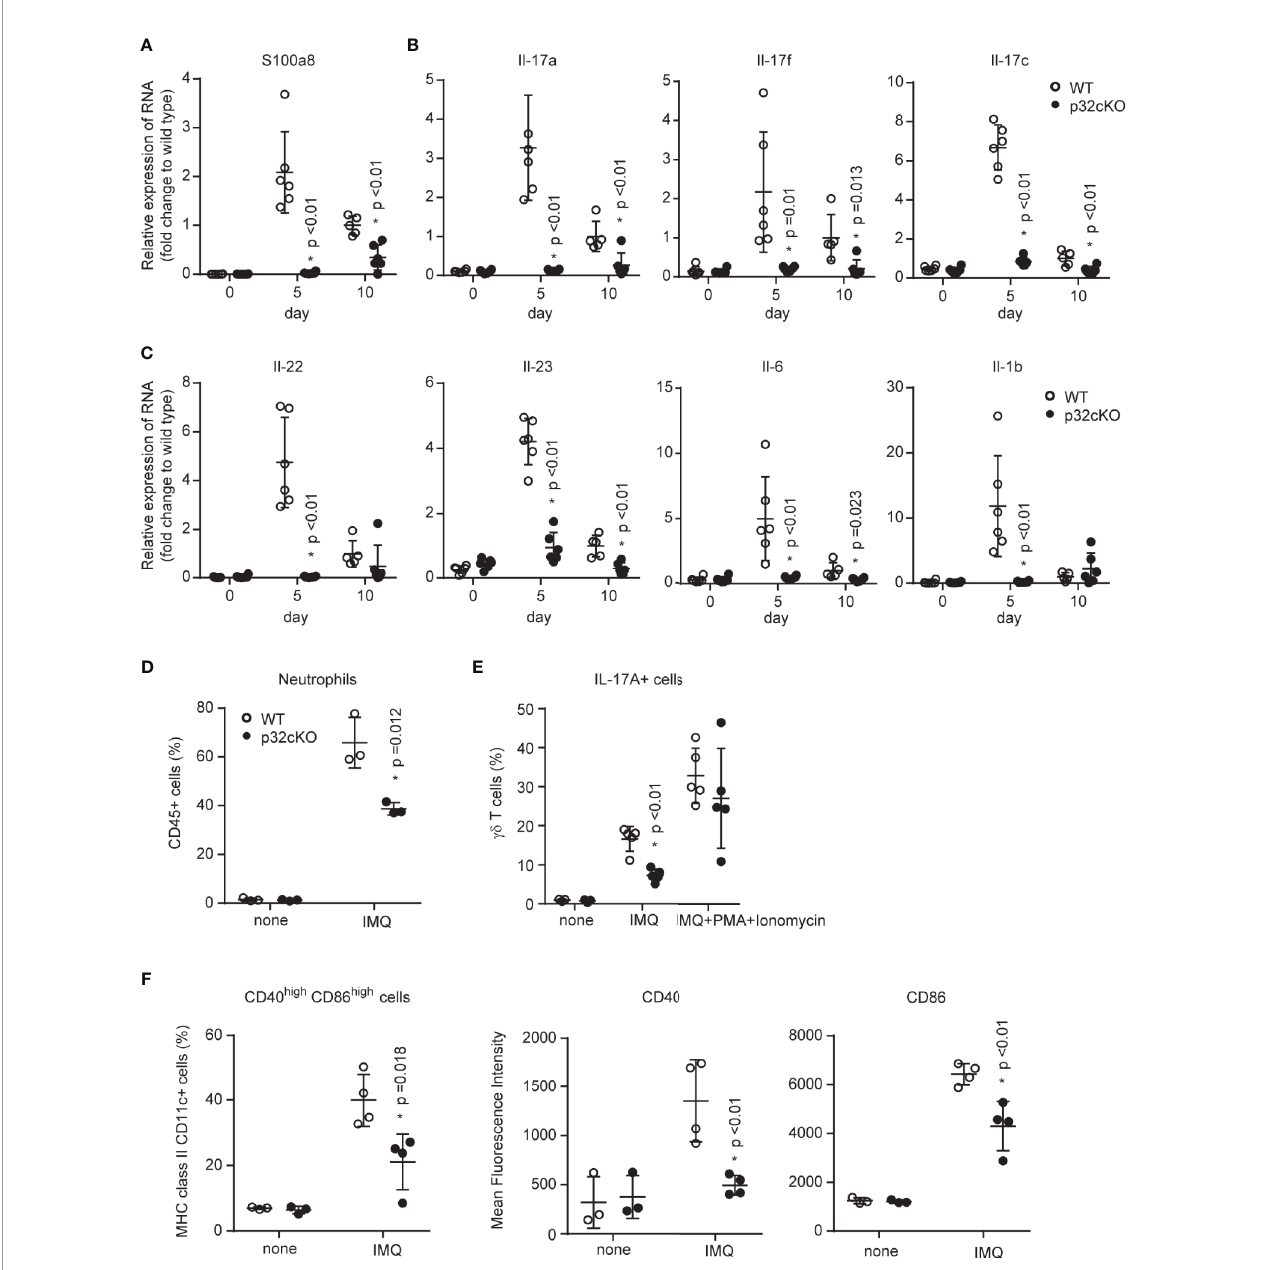
FIGURE 2 | Roles of p32/C1qbp in psoriatic in fl ammation in vivo . (A – C) WT and p32cKO mice were treated with IMQ for 9 consecutive days. Real-time PCR analysis was performed to assess mRNA levels in IMQ-treated mouse ears on days 5 and 10 (n ≥ 3). The results were normalized to 18S expression and are shown as means ± SDs. (D – F) WT and p32cKO mice (n ≥ 3) were treated with IMQ for 4 consecutive days. In fi ltration of neutrophils (D) , IL-17 + gd T cells (E) , and CD40 + CD86 + DCs populations in the ears were analyzed by fl ow cytometry. IL-17 + gd T cell numbers were analyzed before ( E , left and middle lanes) and after ( E , right lane) PMA/ionomycin (PI) stimulation in vitro . Expression levels of CD40 and CD86 were measured in DCs obtained from the ears of WT and p32 cKO mice. Results are expressed as means ± SDs. Data are shown as means ± SDs (A – F) . *p < 0.05 versus WT mice. Data are representative of at least three (A – F) independent